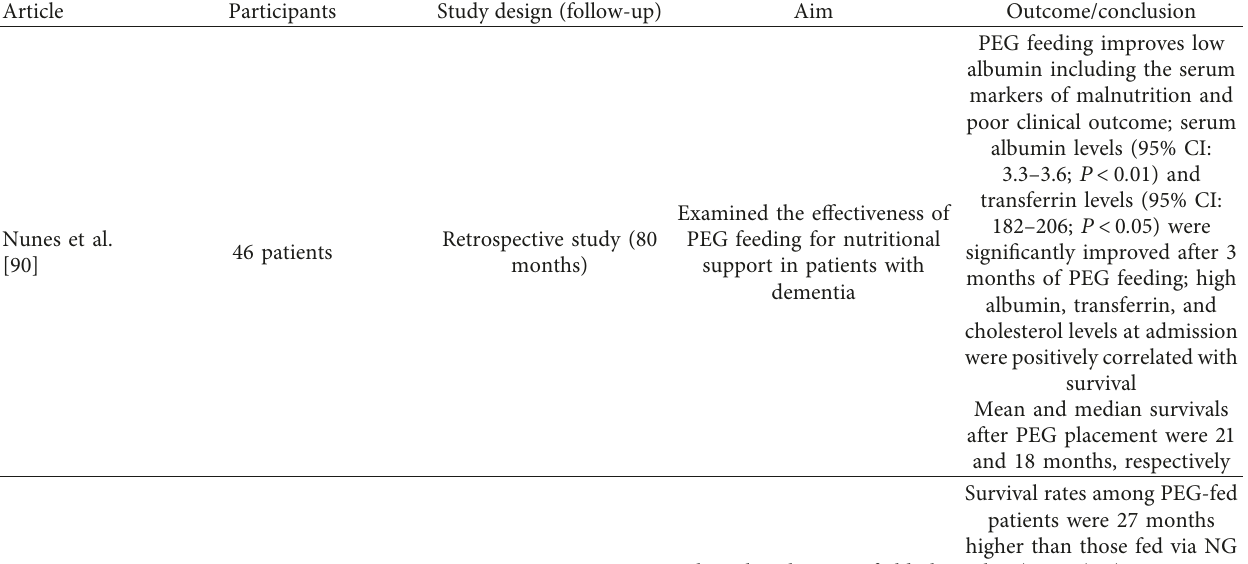
Table 2: Summary of studies on the benefits of tube feeding in individuals with advanced